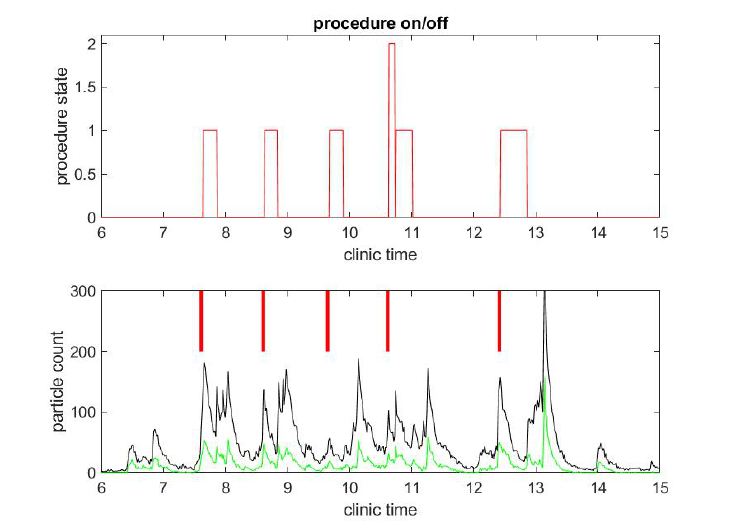
Figure 3. Example of particle counts during a clinical day in a procedural room. ( Top ) the procedure state, 1 for colonoscopy and 2 for EGD procedure; and ( Bottom ) small particle counts (black) and large particle counts (green), along with red bars for marking when the procedure in ( Top )